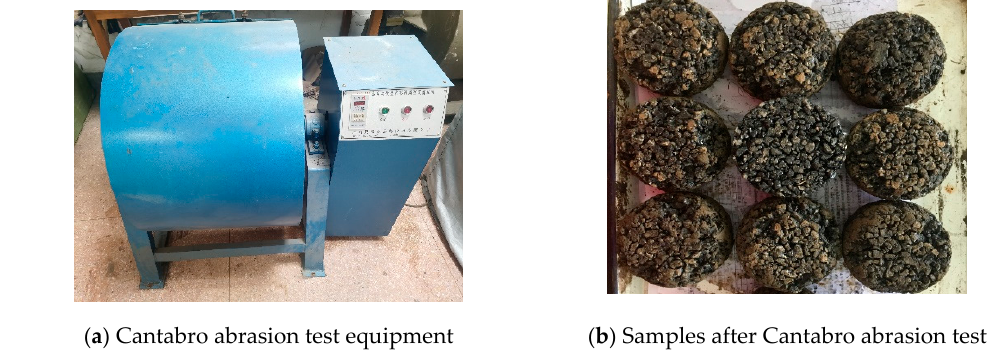
Figure 3. Cantabro abrasion test equipment and samples.